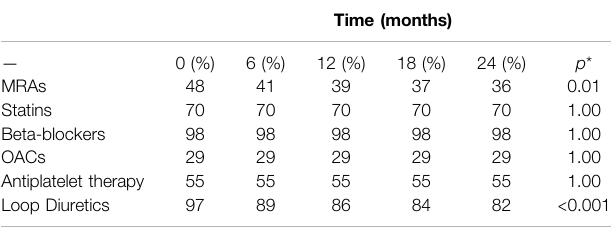
TABLE 2 | Evolution of therapies across